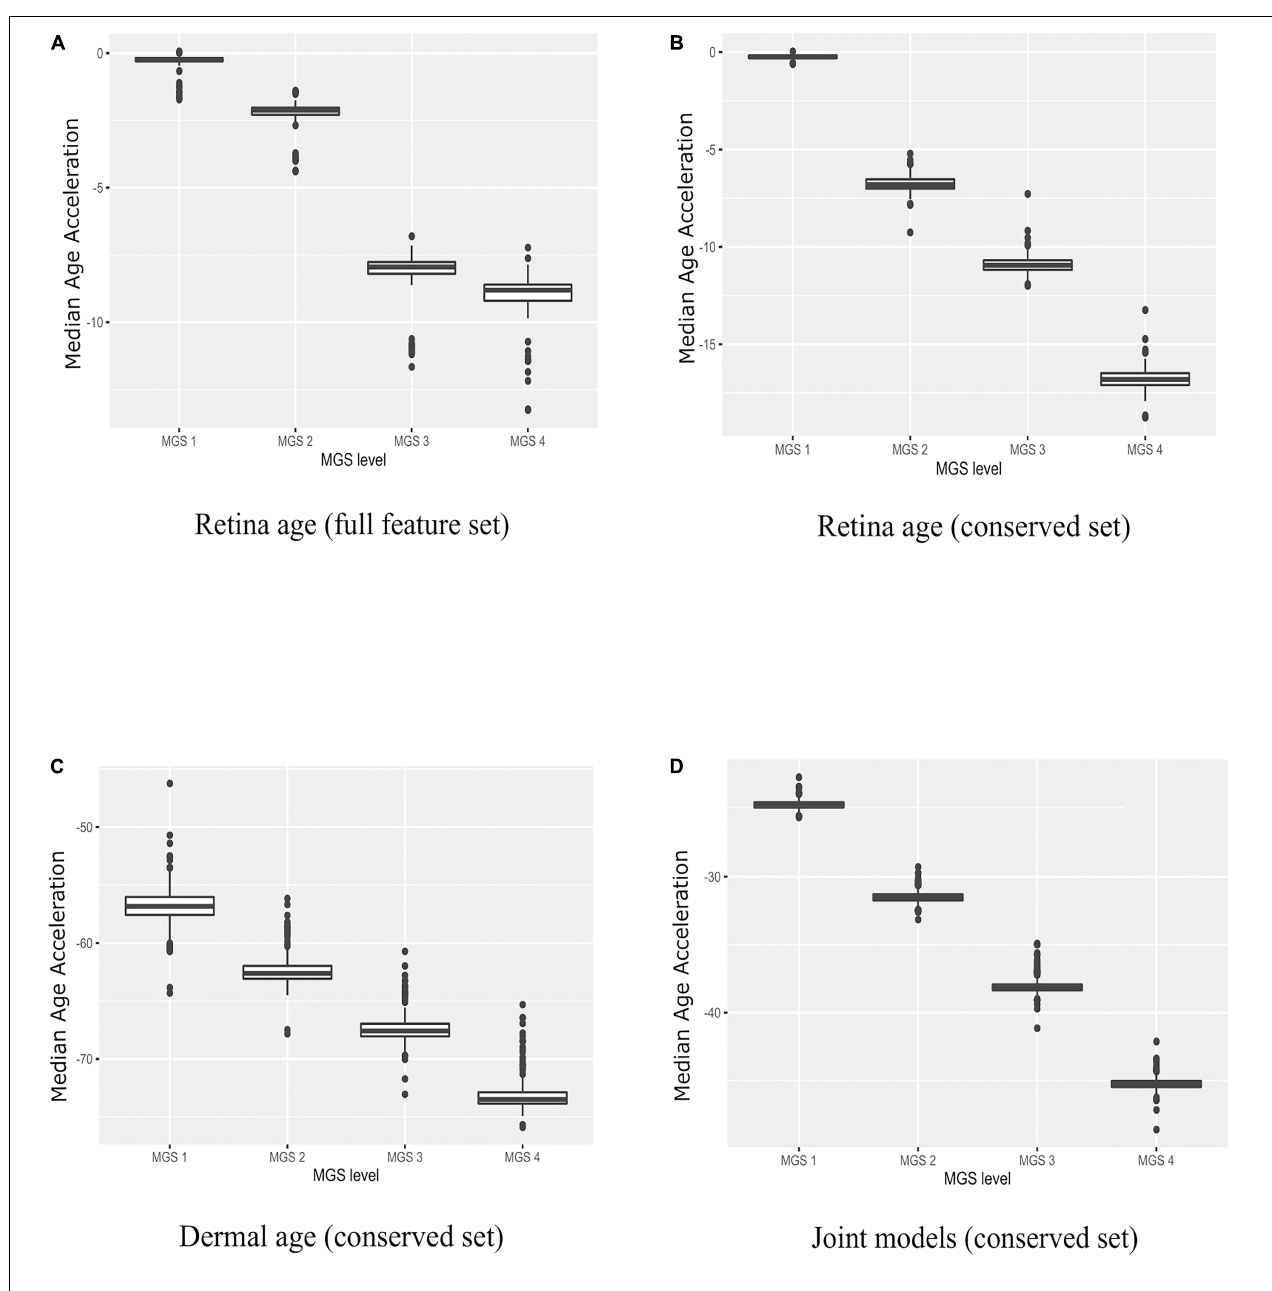
FIGURE 3 | Boxplots of age acceleration in AMD MGS1-4 individuals. (A) Retina age clock models (AMD MGS1, full feature set), (B) retina age clock models (AMD MGS1, conserved feature set), (C) dermal fibroblast age clock models (conserved set), and (D) combined retina-dermal age clock models (conserved set). Shown are median age acceleration for each retina group (AMD MGS1-4) for the different clock models. All four groups are significantly different ( P <